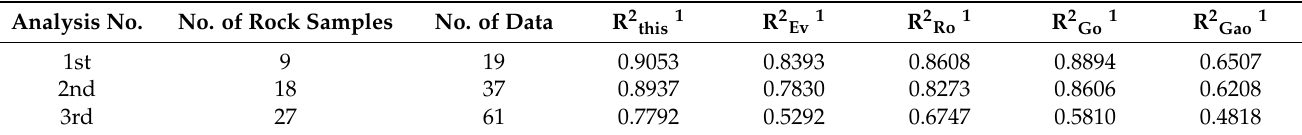
Table 8. Variation of the coefficient of determination in the three analyses.